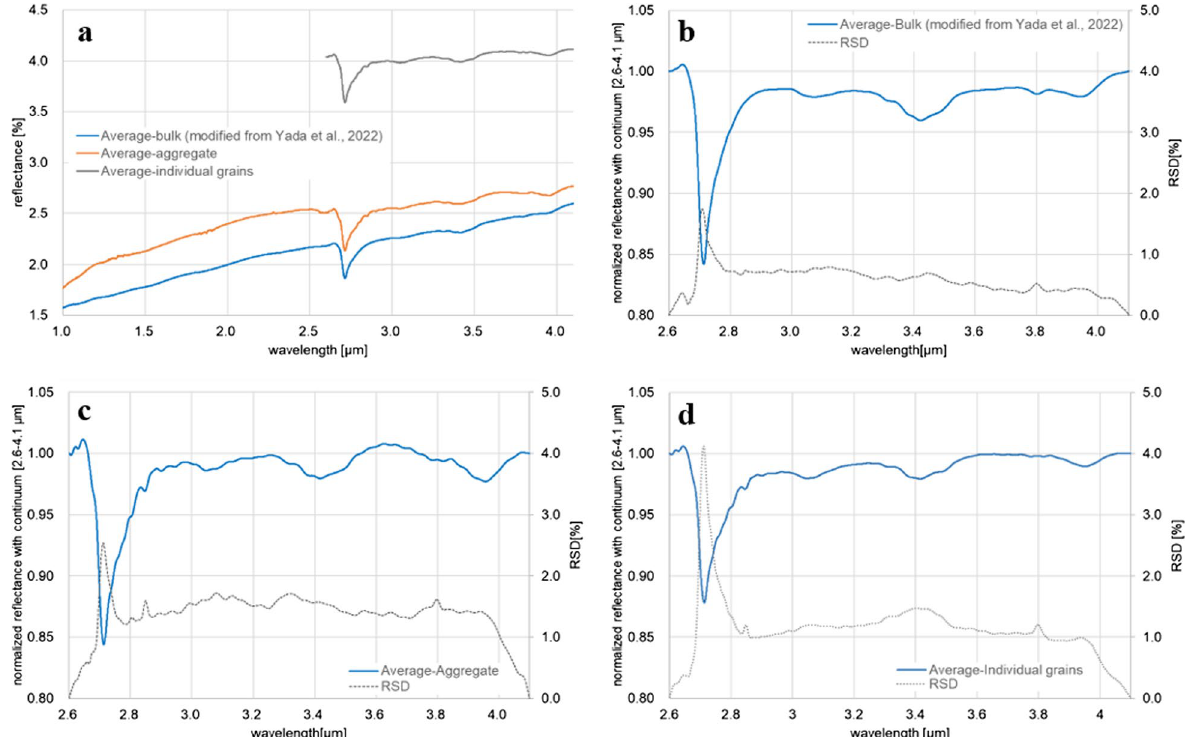
Fig. 10 Comparison of averaged reflectance spectra among the bulk samples, aggregate samples, and individual grains. Averaged a absolute reflectance and normalized reflectance with continuum at 2.6–4.1 μm for b bulk samples, c aggregate samples, and d individual grains. Beam spot size of bulk samples is approx. 6 mm, and that of aggregate samples and individual grains is approx. 1 mm. Relative standard deviation (RSD, %) is also shown in b , c , and